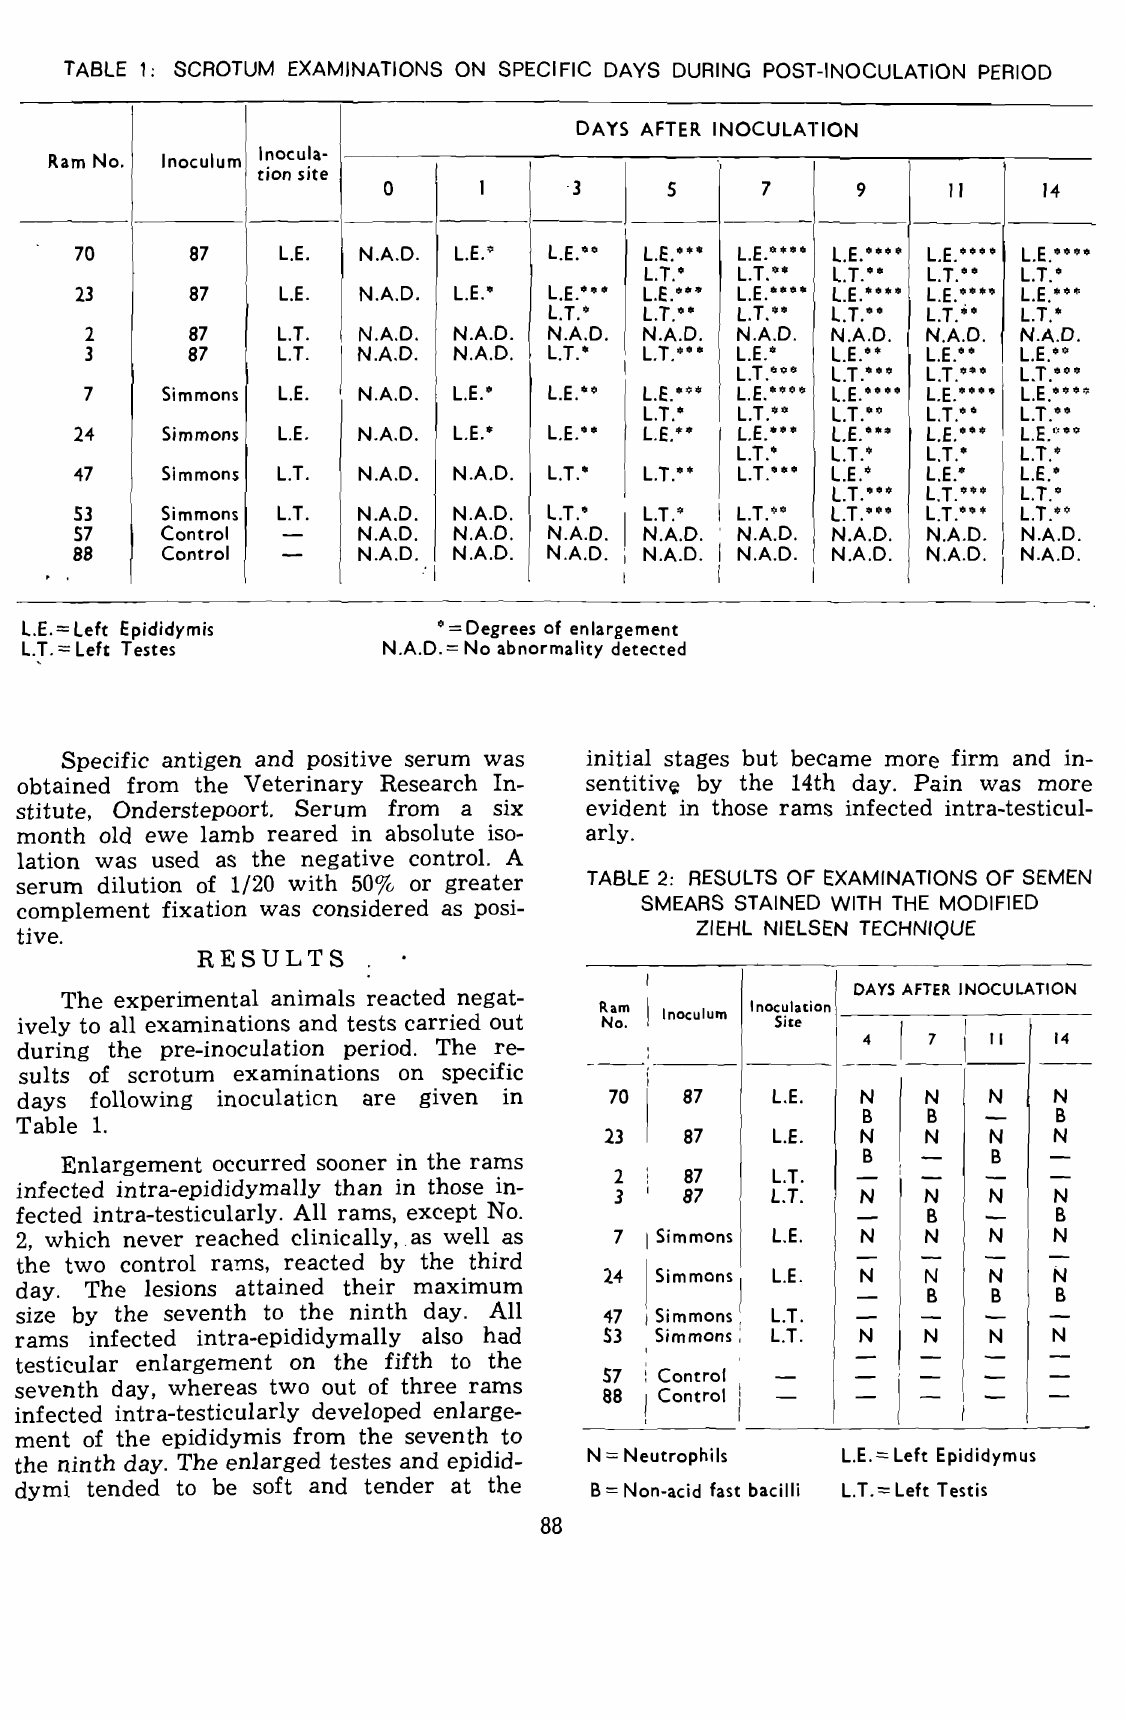
DAYS AFTER INOCULATION